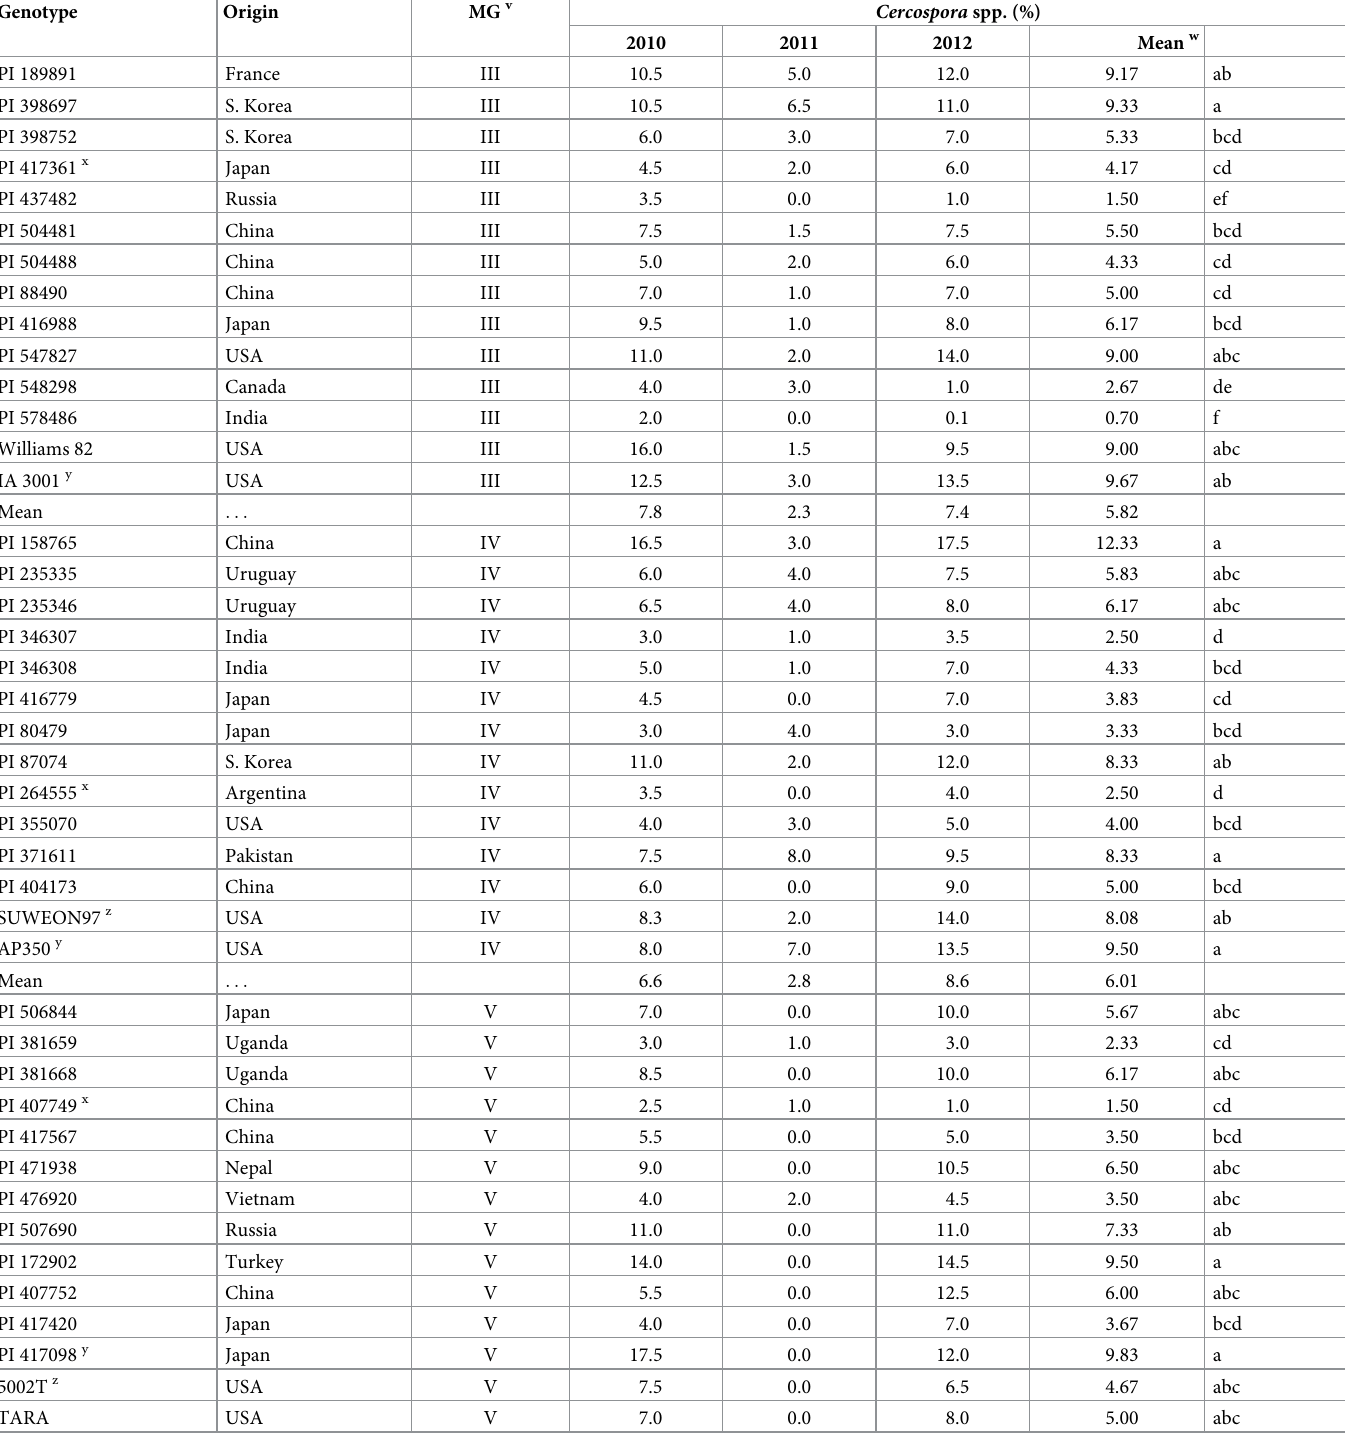
Table 4. Percentage of natural field seed infection by Cercospora species of 42 soybean genotypes in Stoneville, Mississippi, in 2010, 2011, and 2012. Genotype